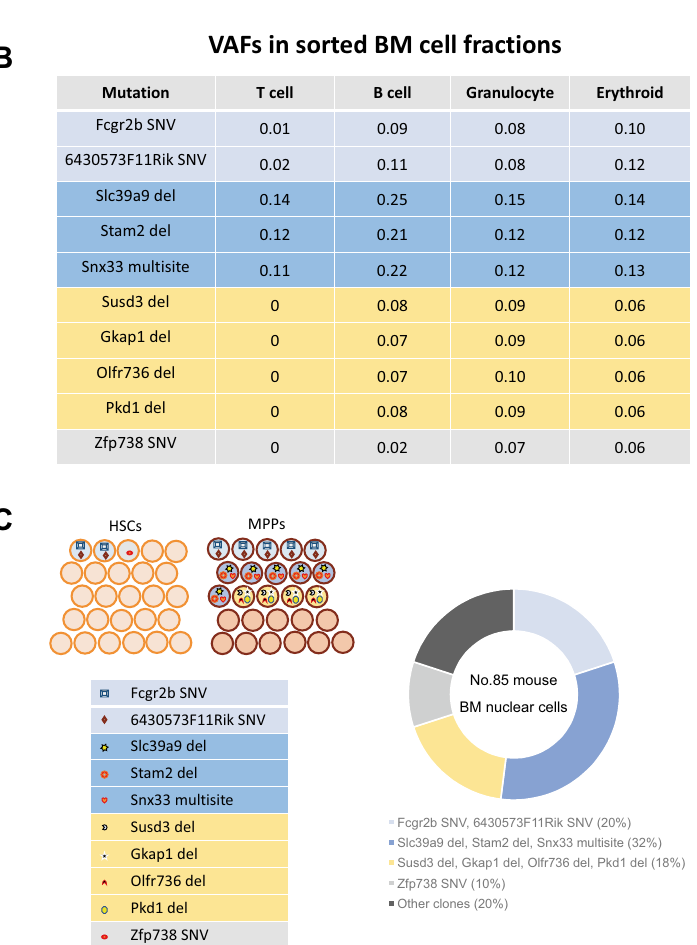
Figure 4. Distribution of CH-associated mutations in several tissues and BM blood cell types in a second irradiated mouse (mouse 85). This mouse was irradiated in a similar manner as was mouse 33 but was evaluated for CH prevalence at the age of 16 months. ( A ) All indicated mutations were undetectable in the brain and testes and rarely in the tail. In contrast, they were detected frequently in the BM and spleen, indicating hematopoietic specificity. ( B ) VAFs of these mutations were 0.02–0.25 in BM B cells, granulocytes, and erythroid cells. However, some were undetectable or scarce in BM T cells. ( C ) Several mutations coexisted in identical hematopoietic colonies from BM HSCs and MPPs, as indicated by the same colors (left panel); these coexisting mutations were distributed in different cell lineages with similar frequencies (also shown in A and B ). Right panel depicts proportions of clonal populations estimated by doubling the VAFs of the mutation in the BM, and their exclusion relationships were derived from the distribution of the clones with different sets of mutations in HSPC colonies. BM, bone marrow; CH, clonal hematopoiesis; HSPC, hematopoietic stem/progenitor cell; MPP, multipotent progenitor; VAF, variant allele